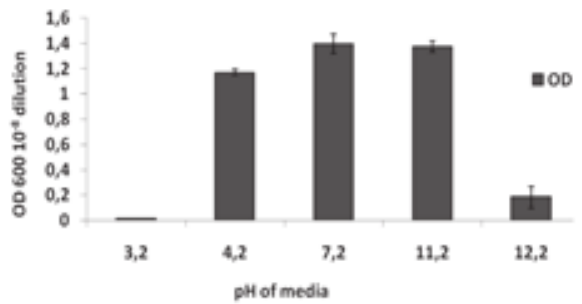
Fig. 2: The growth of tested bacterium A4 in liquid SLP medium treated with different